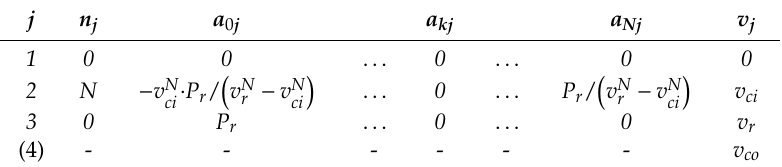
Table 5. Relationship among parameters of the CM and the parameters of the